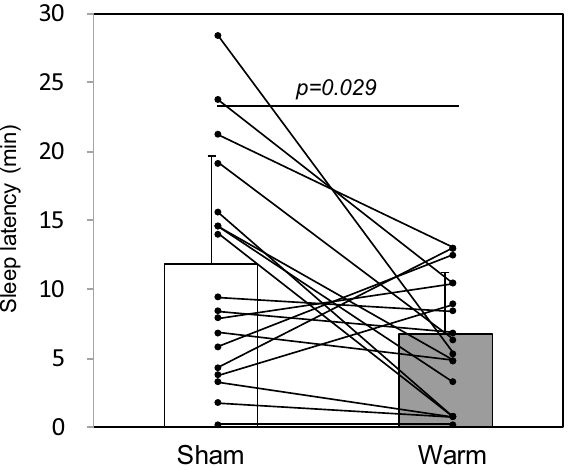
Figure 3. Sleep onset latency (SOL) between the sham and warming conditions. All values are expressed as mean ± SEM of 18 subjects. The scatterplots of the individual SOL are shown. Comparisons were performed relative to the sham condition using the Wilcoxon signed rank test.